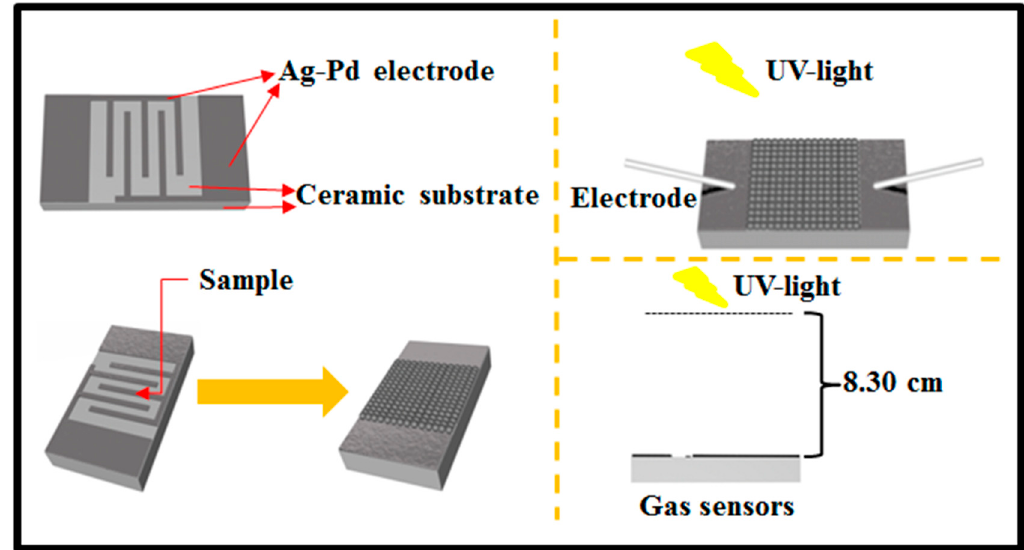
Figure 2. Schematic illustration of the synthetic steps for gas sensor.